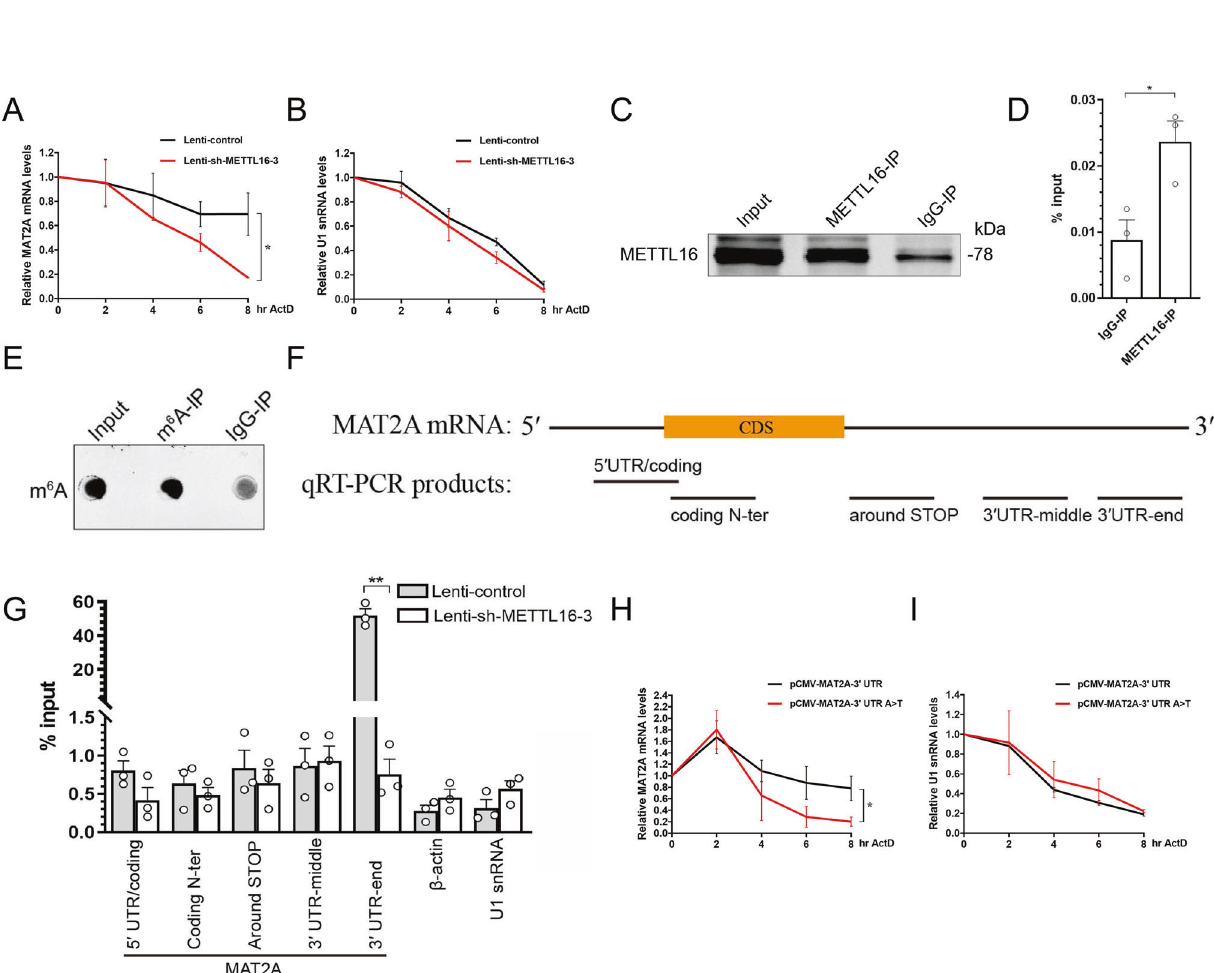
Fig. 6 METTL16 and the METTL16 methylation site on the 3 ′ UTR-end of MAT2A mRNA is required for the stability of MAT2A mRNA. A , B HT22 cells were treated with 5 μ g/ml ActD for up to 8 h with or without prior knockdown of METTL16. The expression levels of MAT2A mRNA ( A ) and U1 snRNA ( B ) were measured on the 0, 2, 4, 6, and 8 h after the ActD addition ( n = 3). C , D RIP-qRT – PCR was employed to investigate the direct interaction of METTL16 protein and MAT2A mRNA in the HT22 cells. Immunoblot analysis of METTL16 was performed as a control ( C ). MAT2A mRNA was assessed by qRT – PCR in endogenous METTL16, or IgG (negative control) immunoprecipitates from HT22 cells and are shown as percentages of input RNA ( n = 3) ( D ). E – G Anti-m 6 A RIP-qRT – PCR using total RNA from HT22 cells with or without METTL16 knockdown. Immunoblot analysis of m 6 A was performed as a control ( E ). Cartoon render of the PCR products in MAT2A mRNA ( F ). The indicated transcripts of MAT2A mRNA ( F ), β -actin, and U1 snRNA were quanti fi ed by qRT – PCR and are shown as percentages of input RNA ( G